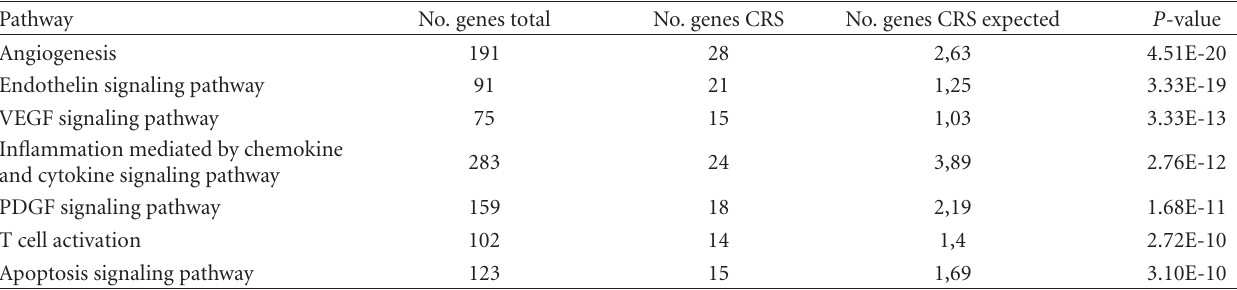
Table 3: List of enriched biological pathways. Given are the total number of genes assigned to a process/function, the number of genes assigned as derived from literature mining for CRS, the number of genes expected from a statistical perspective, and the significance level of